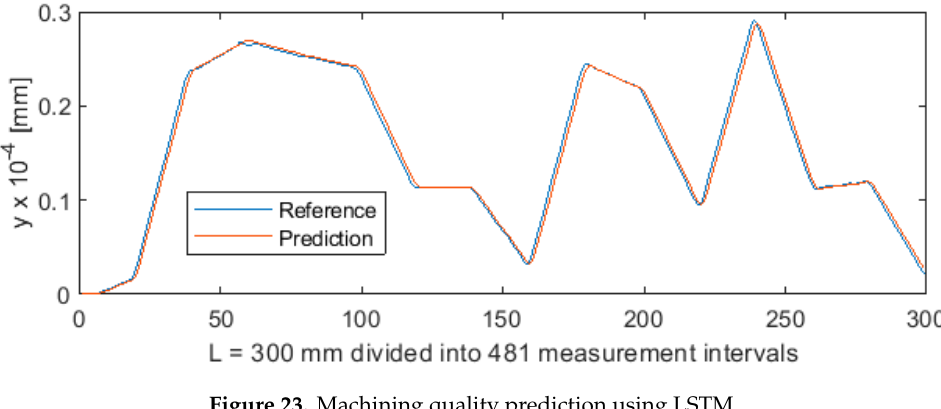
Figure 23. Machining quality prediction using LSTM.